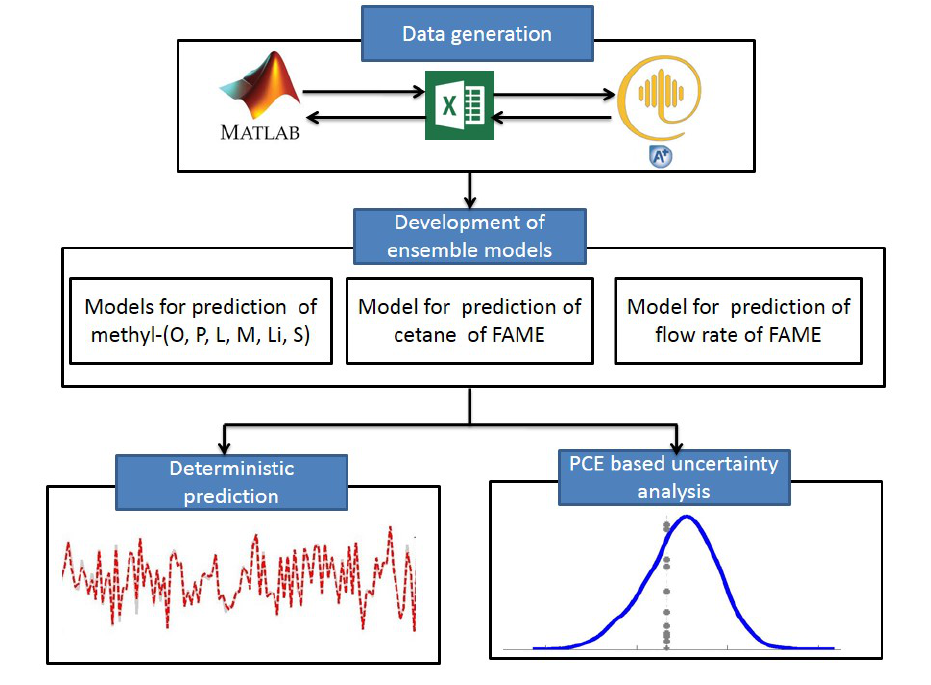
Figure 4. Proposed modeling